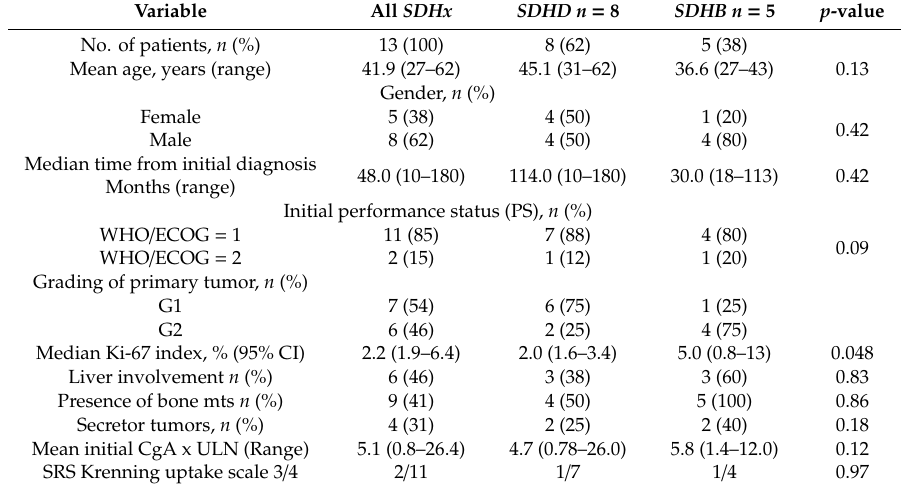
Table 1. Baseline demographic, clinical and pathological characteristics for the overall group and the subgroups of patients with SDHD and SDHB mutation.